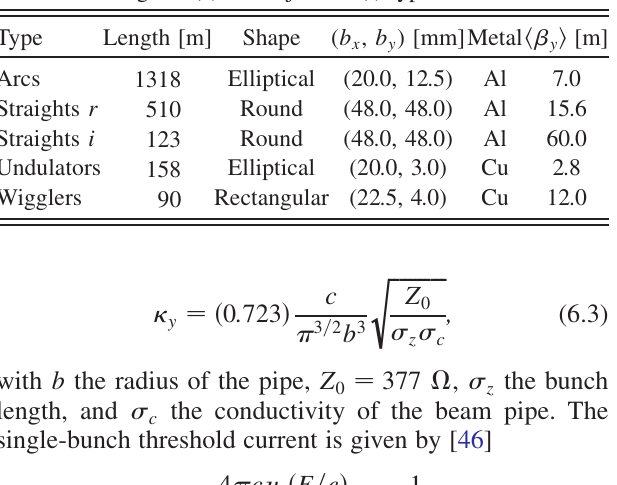
ULTIMATE STORAGE RING BASED ON FOURTH-ORDER . . TABLE VI. PEP-X beam pipe chamber types, giving total length, cross-sectional shape, half-height in x and y , type of metal coating, and average beta function. Note that straights are divided into regular ( r ) and injection ( i ) types.